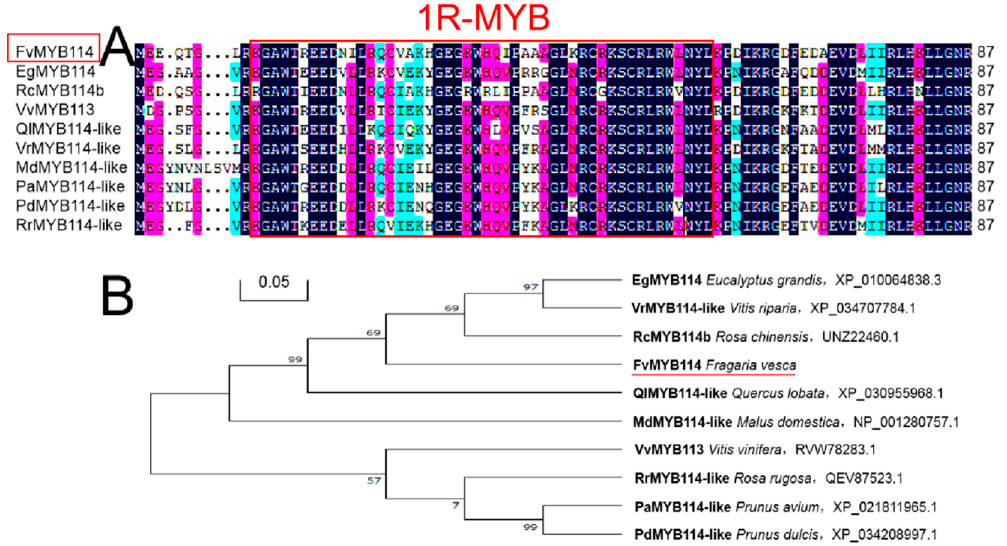
Figure 1. Comparison between FvMYB114 and MYB proteins of other species and their homologous evolution. ( A ) Analysis of homology between FvMYB114 and MYB proteins of other species. The